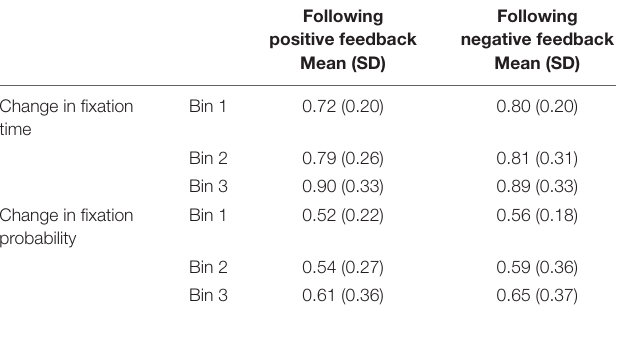
FIGURE 4 | Proportion change in fixation probability following positive (black solid line) and negative feedback (gray dashed line) in each of the three